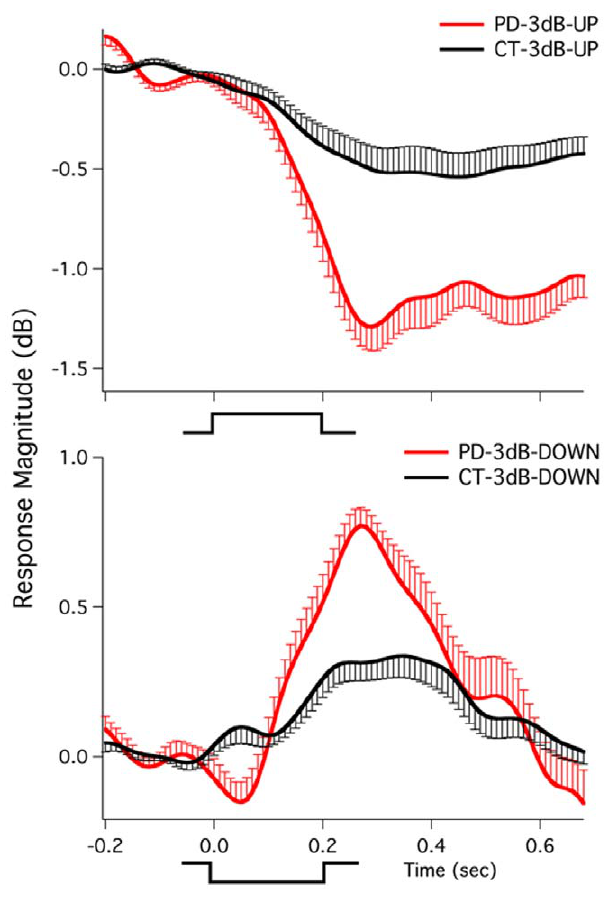
Figure 2. Grand-averaged vocal responses to upward (top) and downward (bottom) 6 dB perturbations across all PD and control subjects. See Figure 1 for details.